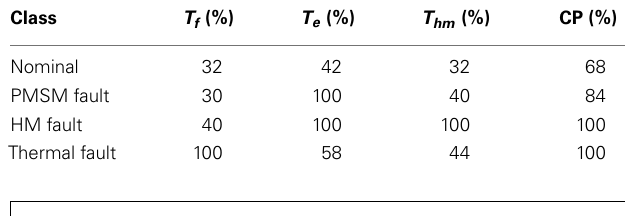
Table 3 | Fault classification accuracy by exhaustive fusion .